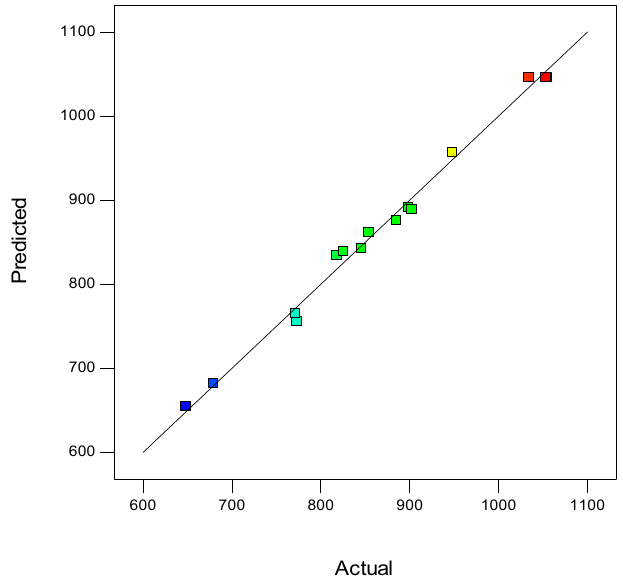
Figure 8. The actual versus predicted plot.